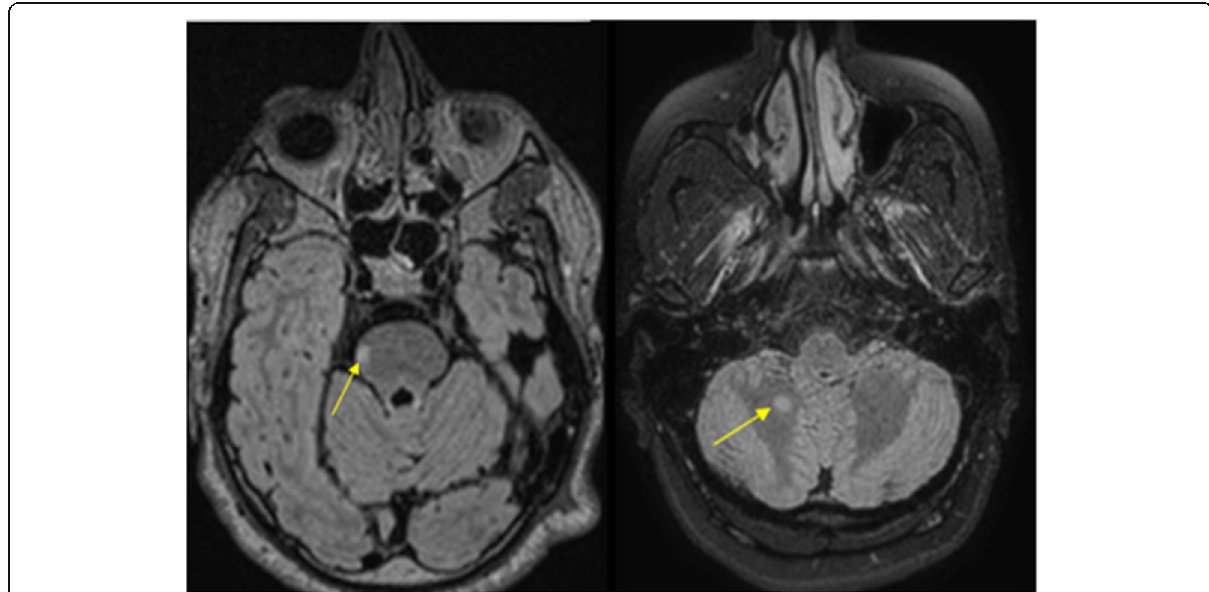
Fig. 6 Axial 3D FLAIR sections showing infratentorial white matter